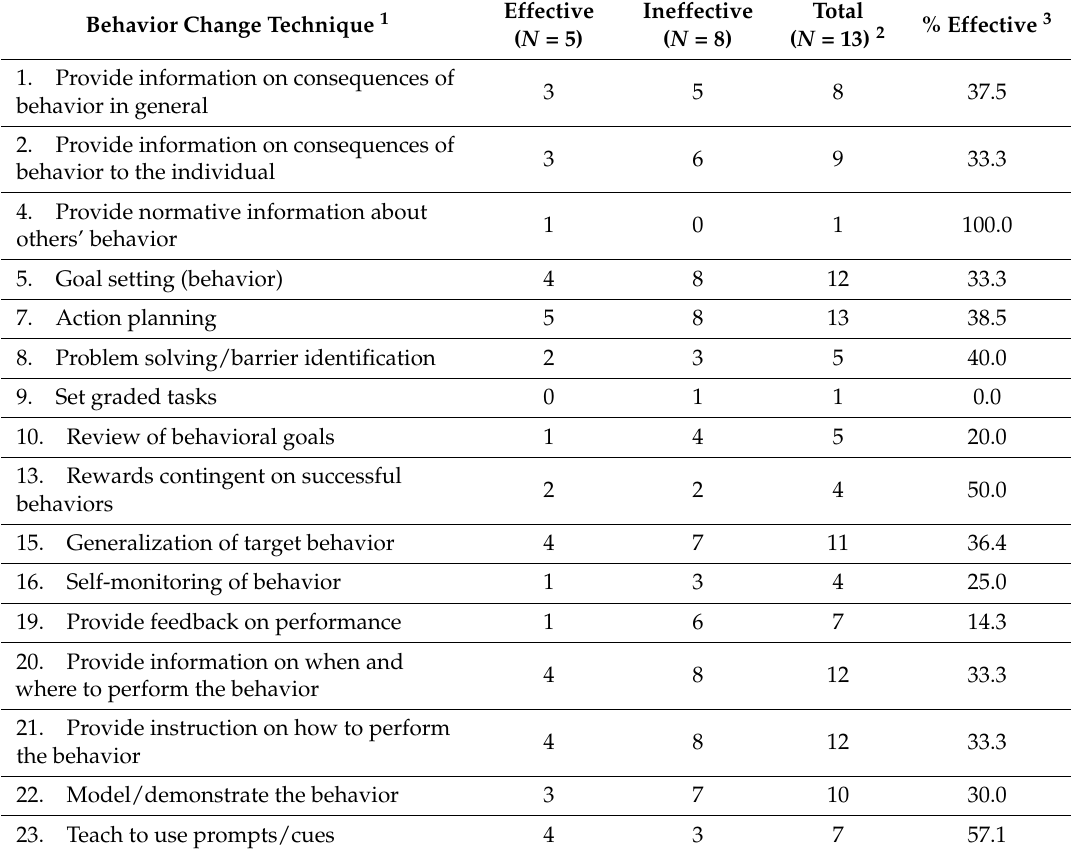
Table 4. Behavior change techniques associated with intervention